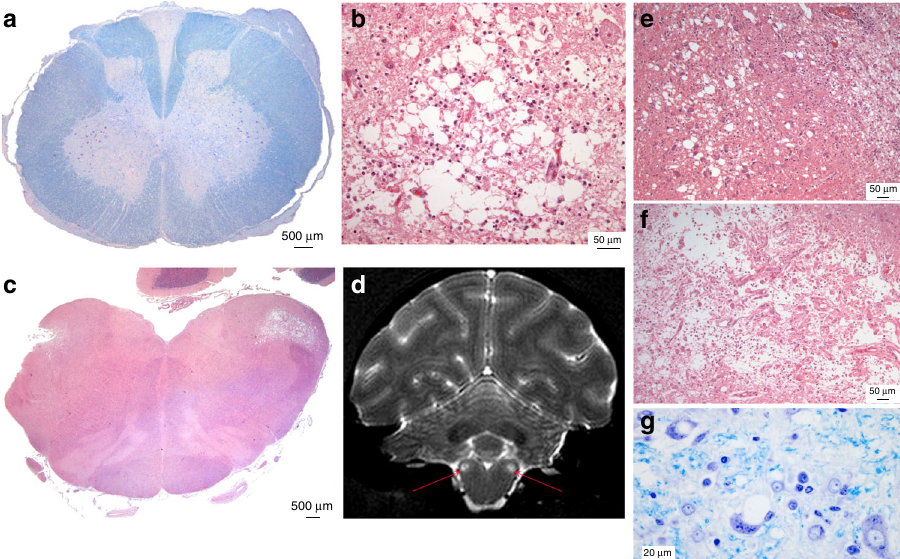
Fig. 3 CNS lesions in atypical primate infections. a Bilateral, medial pseudo-necrotic lesions of the anterior horns with neuronal loss in the lower cervical spinal cord extended in some cases up to C4 (Primate R8. C6 spinal cord. Klüver – Barrera/KB stain). Wallerian degeneration of the posterior spinal tracts (mainly gracilis) was also observed along the whole length of the spinal cord and in parts of the optic tracts (Supplementary Fig. 4). Atrophic ganglion cells were noted in dorsal root ganglia. b At higher magni fi cation, lesions appeared as a loss of ground substance fi lled with macrophages and surrounded by glial cells with few preserved neurons (haematoxylin – eosin/H&E stain). There were no in fi ltrates of lymphocytes or granulocytes, haemorrhages, fi brin deposits, vascular obstructions or thickened vessels. c The same type of bilateral pseudo-necrotic lesion was observed in the brainstem within the spinal nuclei of the trigeminal nerve and extended in some cases to the inferior cerebellar peduncles (Primate R6, H&E stain). d Those lesions (arrows) might be visualised with MRI analysis (primate R16, terminal stage of the disease). Coronal T2-weighted images were acquired using a fast spin-echo sequence (TE/ TR = 60/4000, 450 × 450 µ m in plane resolution, 1 mm slice thickness, 40 slices, 14 min acquisition time). In these foci, involvement of the nervous tissue was of different degrees, ranging from status spongiosus like ( e ) (primate R16, H&E) to cavitation with myelin debris and axonal loss ( f ) (primate R6, H&E). g At the periphery of the lesions, intracellular vacuoles were detected in some neurons (primate R17, KB